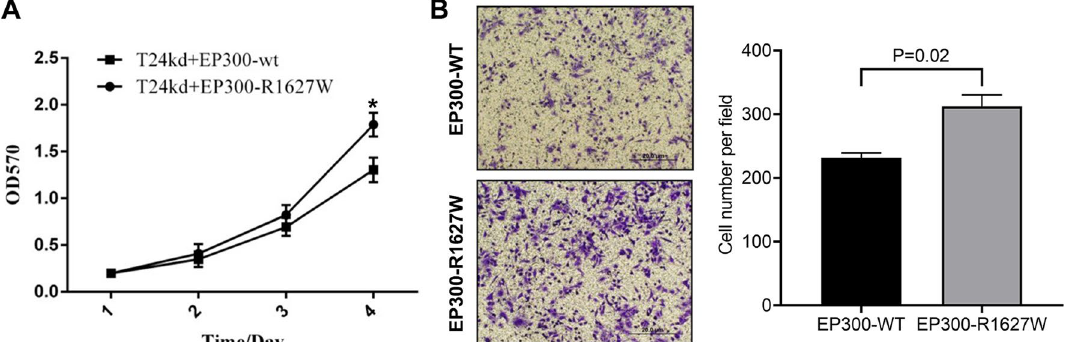
Fig. 4 EP300-R1627W promotes BCa cell growth and invasion. A Growth curve of EP300-R1627W and EP300-wt in T24-EP300kd, respectively. B The invasion assay shows that cells containing EP300-R1627W are more aggressive than cells containing EP300-wt. Values are represented as mean ±